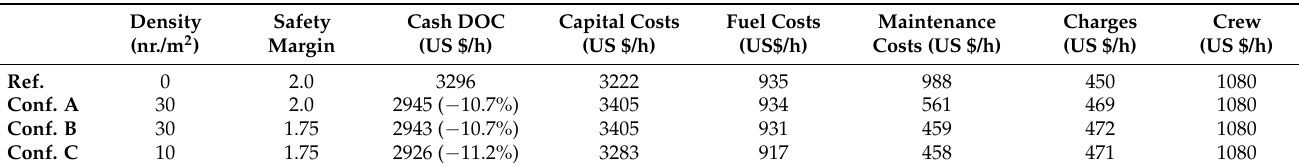
Table 15. Operating Costs breakdown for configuration C (compared with all configurations ana- lyzed).